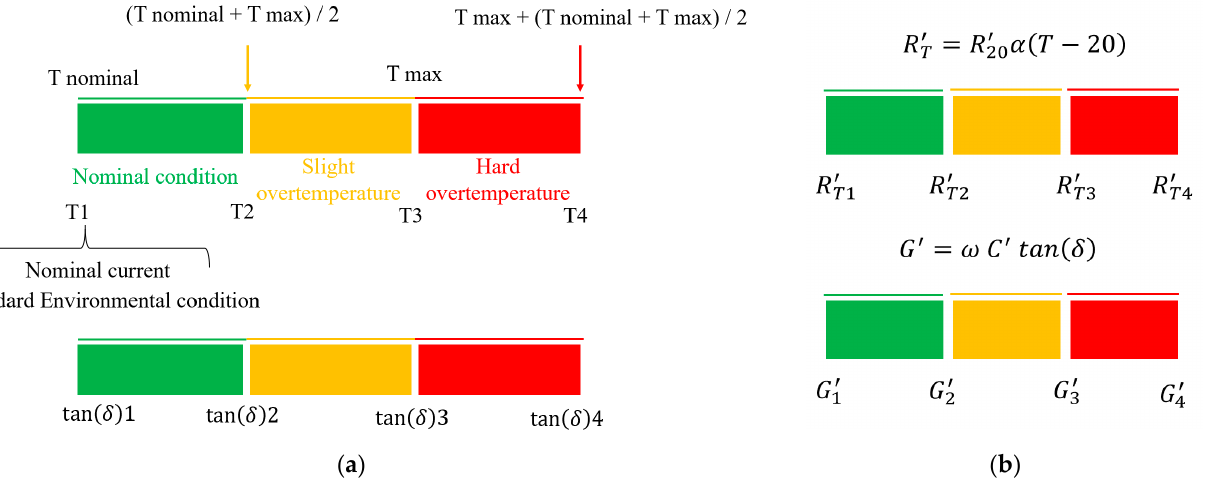
Figure 3. Fault classes: ( a ) Temperature intervals and tan ( δ ) intervals used to describe the health state of the cable; ( b ) Corresponding variations of resistance and conductance.